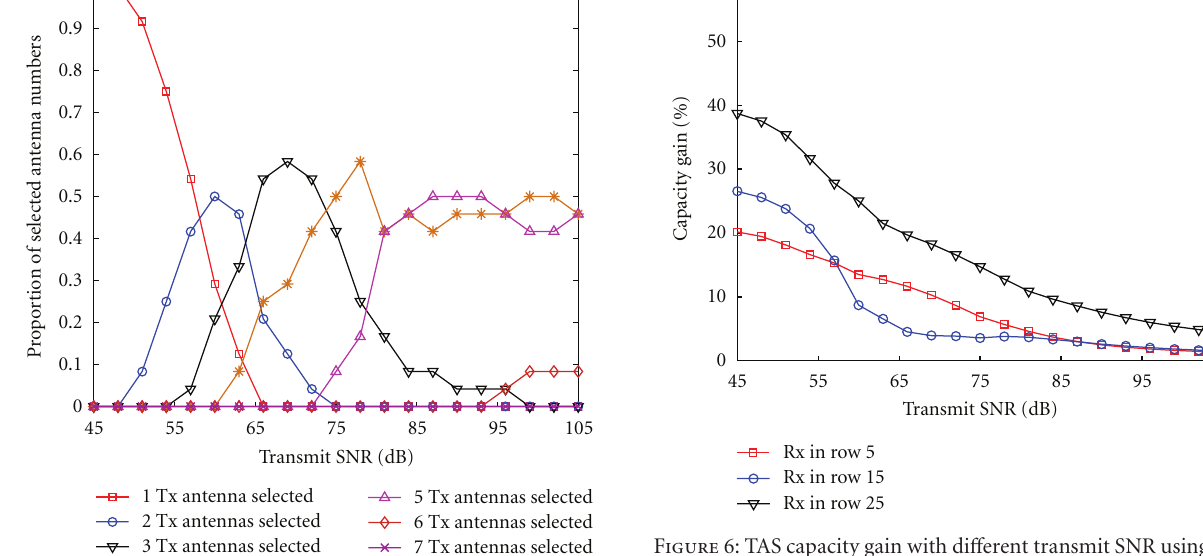
Figure 6: TAS capacity gain with di ff erent transmit SNR using Rx1, Rx4, and